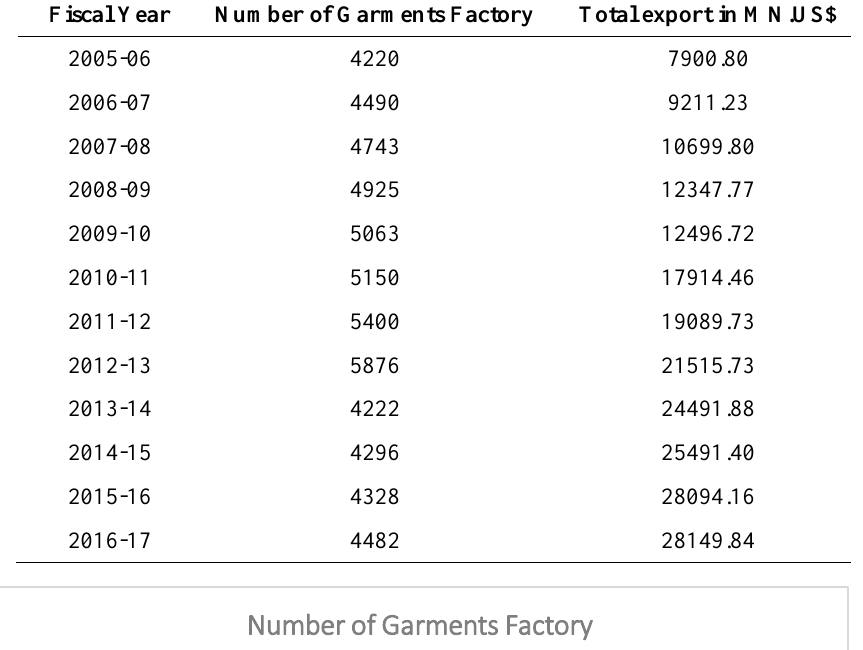
Number of Garments